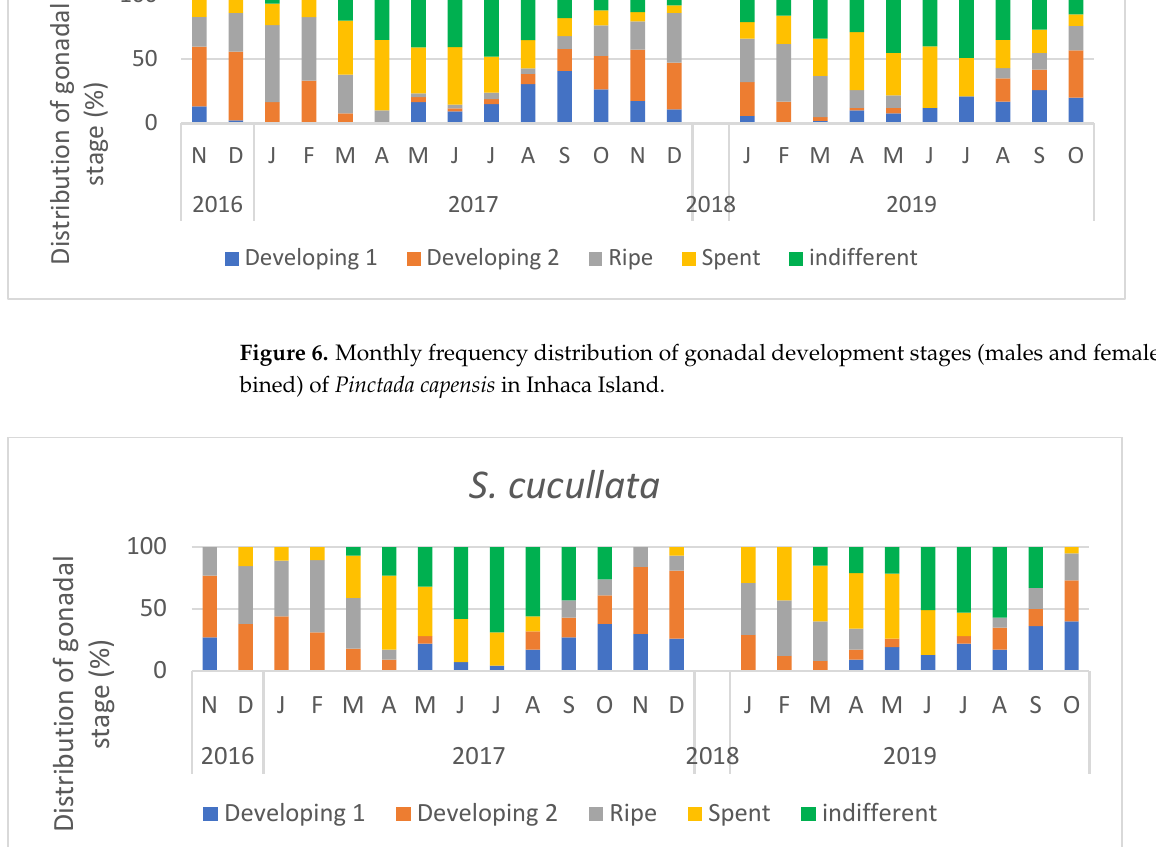
Figure 7. Monthly frequency distribution of gonadal development stages (males and females com- bined) of Saccostrea cucullata in Inhaca Island.